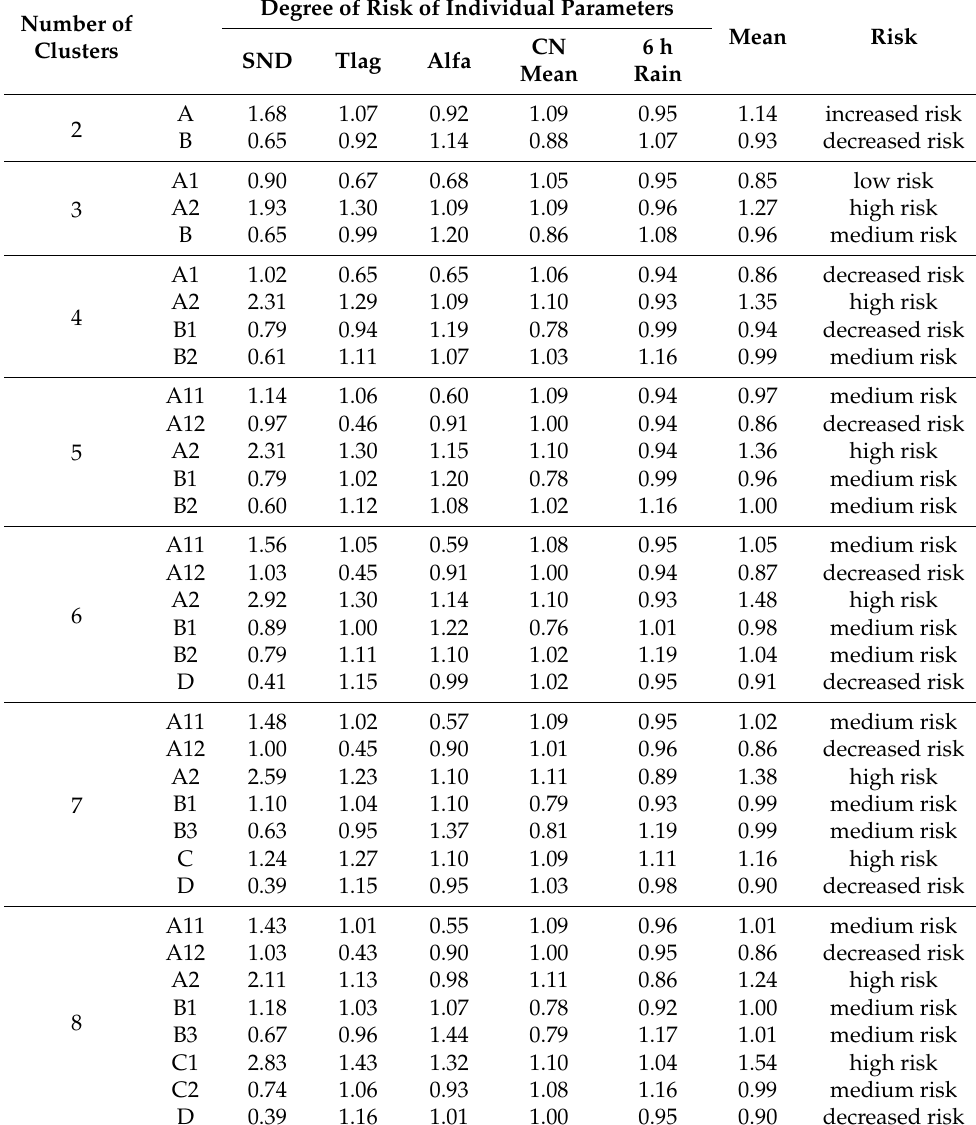
Table A2. Table of the development of the classification of catchment groups produced by cluster analysis according to the degree of risk during the progressive formation of two to eight